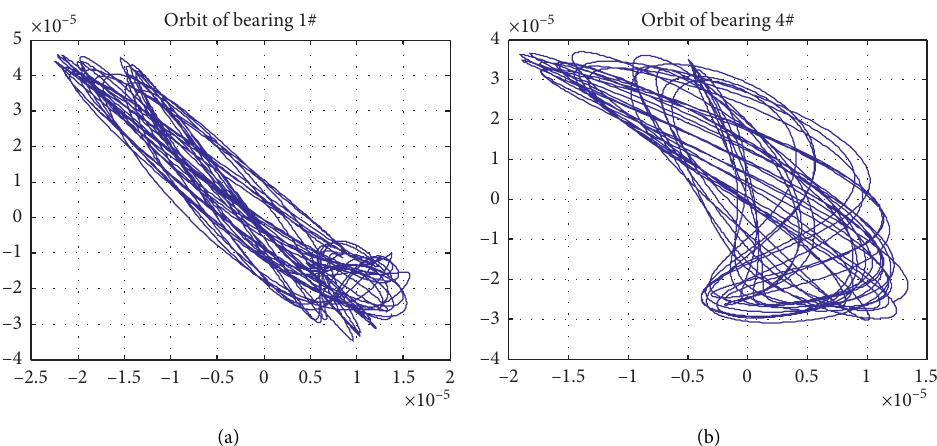
Figure 29: Orbits of bearings with misalignment ( Δ � 0.2mm, Ω